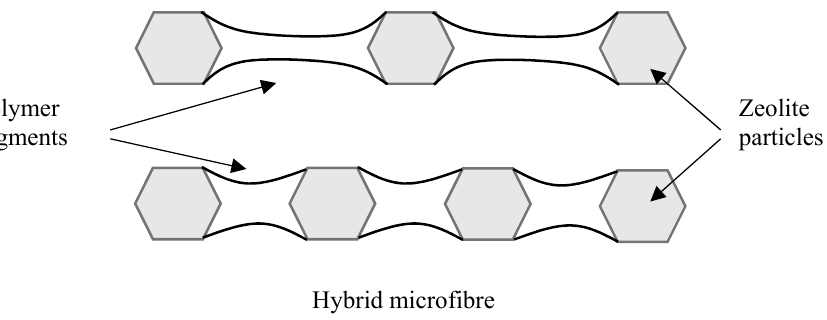
Figure 8. Scheme of a microfibre as the number of zeolite crystals increases.